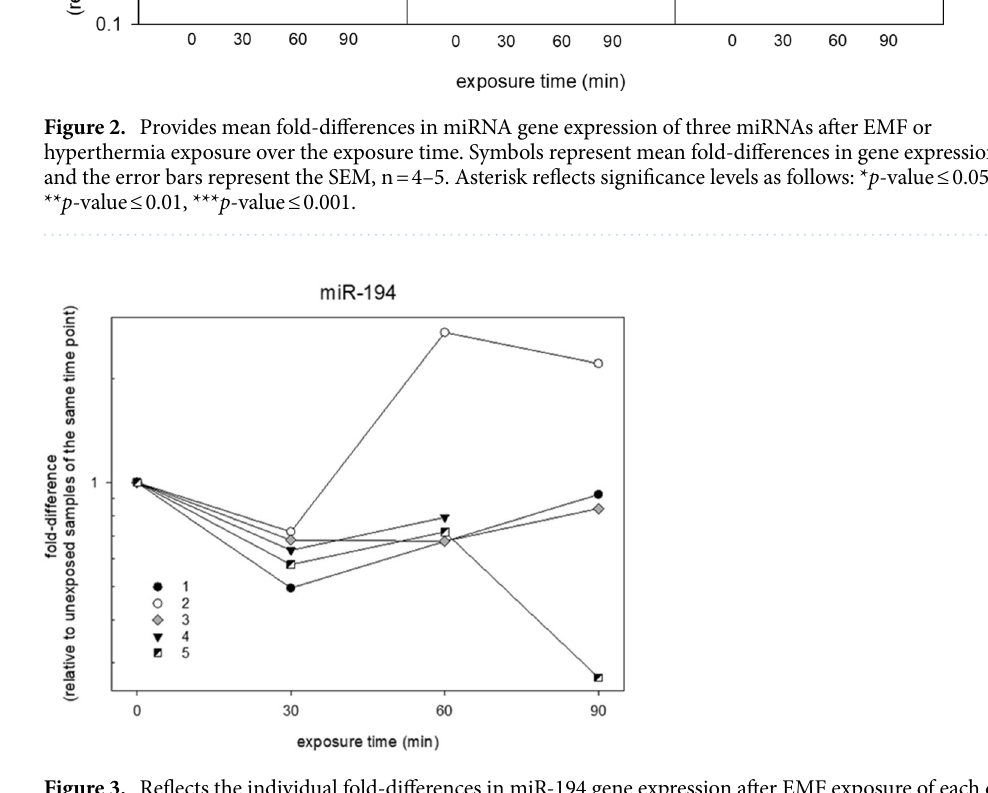
Figure 3. Reflects the individual fold-differences in miR-194 gene expression after EMF exposure of each donor over the exposure time which was only detected during the screening study in